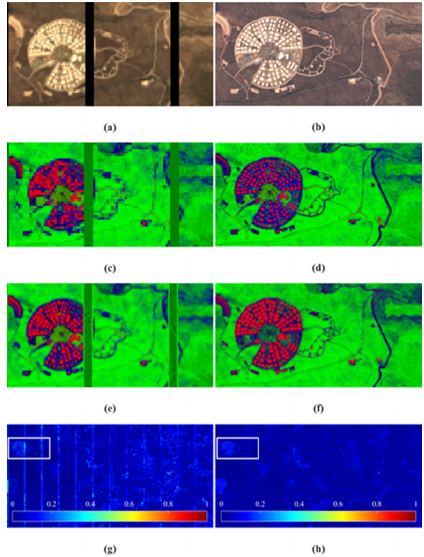
Figure 15. Zoon-in on the abundance fraction maps for three dominant EMs in the selected area for Test 4. ( a , b ) present RGB composites of the Landsat (with simulated missing-data stripes) and Sentinel images, respectively. ( c , d ) present corresponding fraction maps as obtained using the original spectral images with LSR 30 m and HSR 10 m (used as GT), respectively. ( e , f ) present corresponding fraction maps with HSR 10 m, as obtained using the image retrieved by the PSQ-PS method, and as obtained by the proposed fusion method DFuSIAL, respectively. ( g , h ) present full MAE maps of the fractions obtained by the PSQ-PS and DFuSIAL methods, respectively. The white rectangle in ( g , h ) marks selected zoom-in area. Remote Sens. 2020 , 12 , x FOR PEER REVIEW